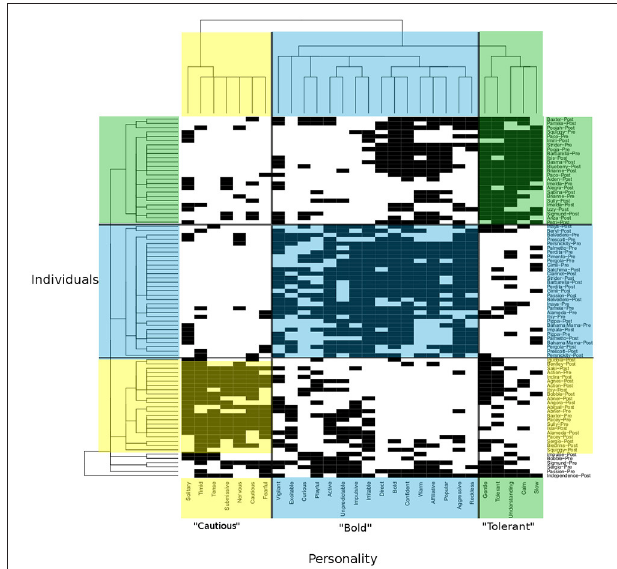
FIGURE 5 | Data Mechanics tree and heat map representing bipartite network analysis of clusters of individuals (macaques) set on the Y-axis with clusters of personality type on the X-axis. Note the blocks of individuals sharing personality profiles on the Y-axis as well as the blocks of personality traits on the X- axis. For illustration for the level in the tree where the red line is located, we can block personality according to individuals and individuals according to personality (highlighted yellow, blue, and green boxes). Note how individuals who are similar in personality profiles group together and personality traits corresponding to personality types group